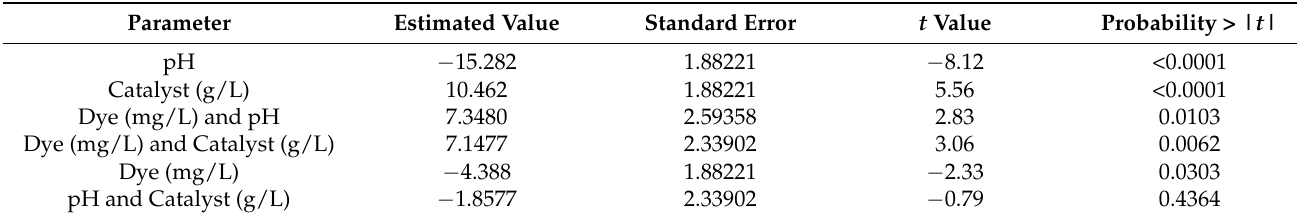
Table 6. Estimated regression coefficients.